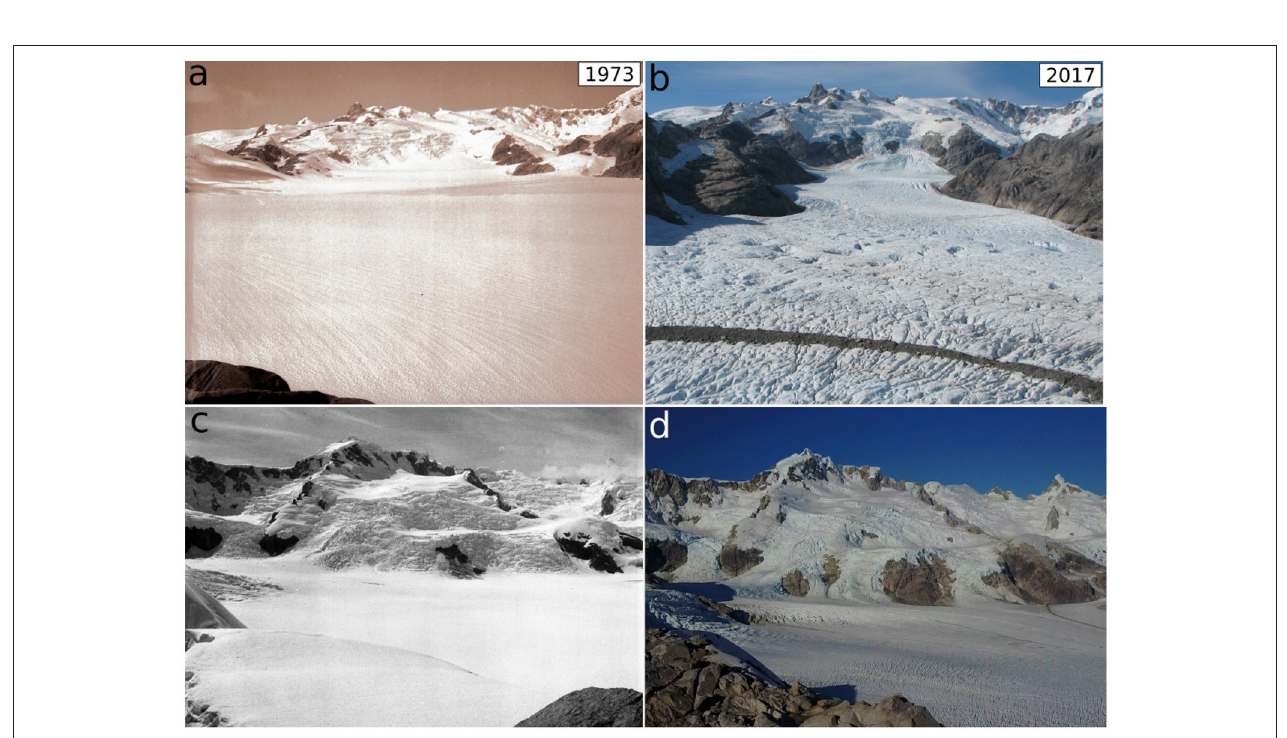
FIGURE 3 | Photographs taken from the British Joint Forces Expedition in 1973 and again in 2017 demonstrate changes in glacier surface elevation. (a,b) Looking east-northeast at the northern tributary that flows into the main truck of Benito Glacier near our field camp ( Figure 1B ). (c,d) Looking directly east toward the semi-circular range of unnamed mountains that surround Benito